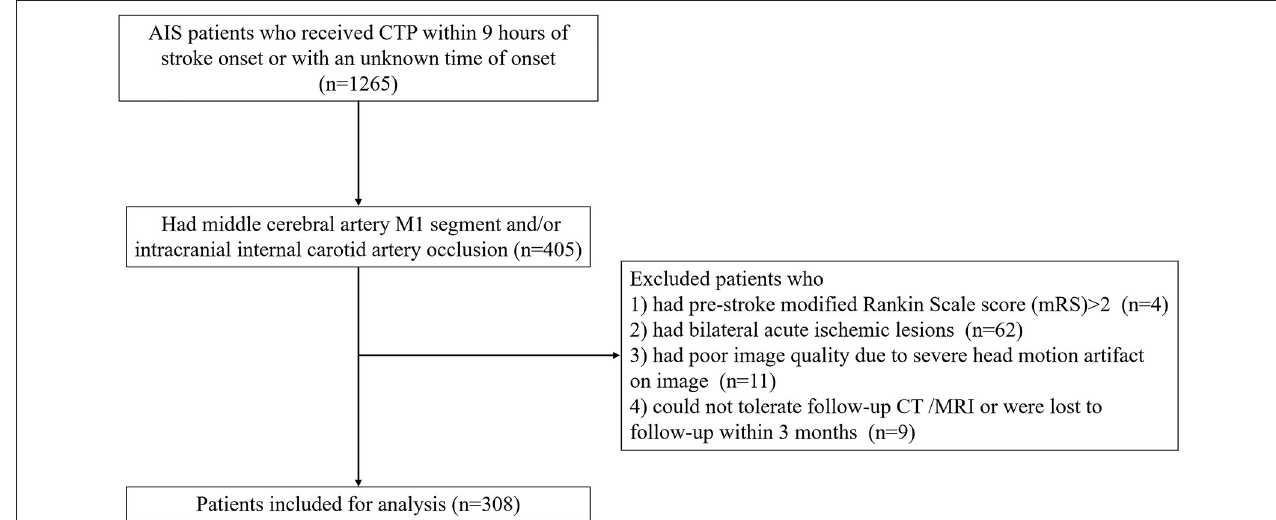
FIGURE 1 | The flowchart of inclusion and